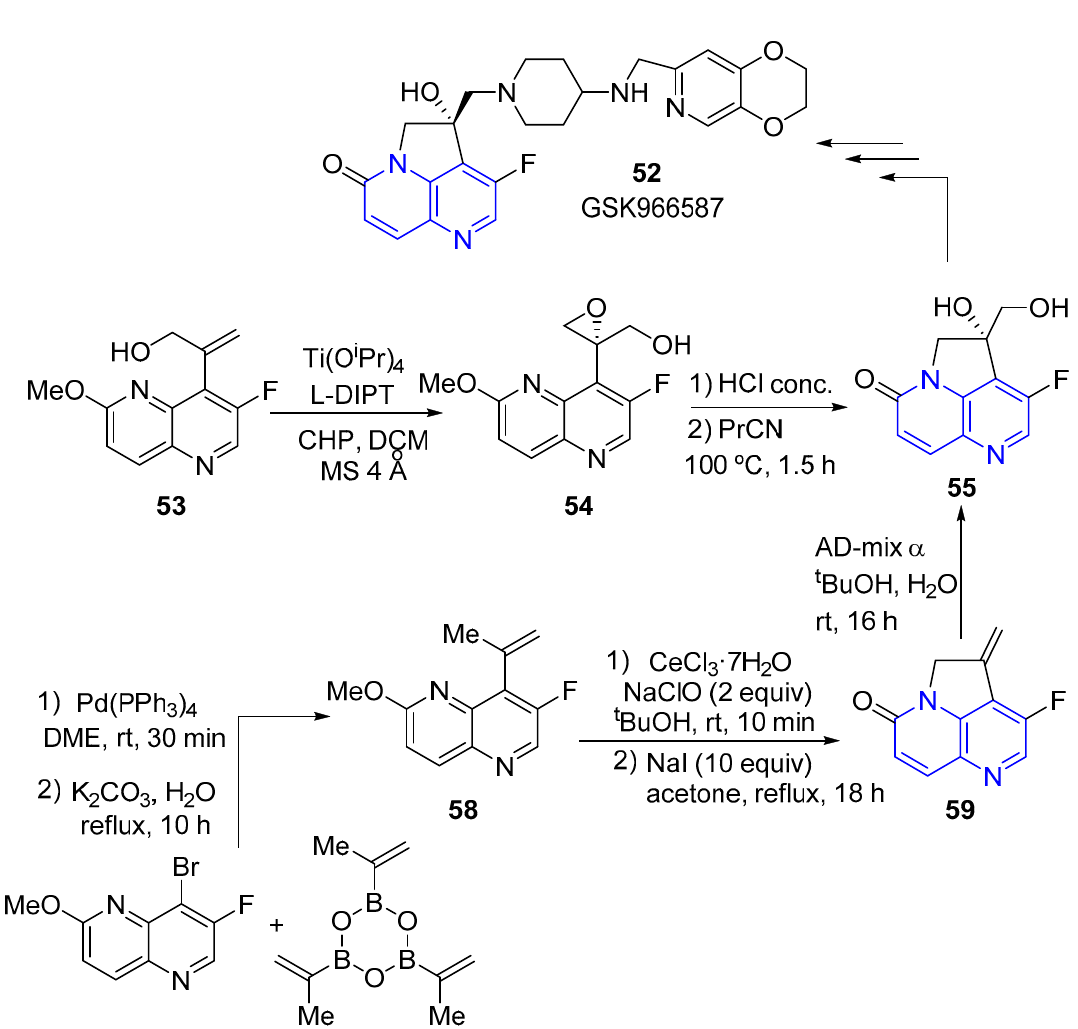
Scheme 16. Enantioselective total synthesis of the potent antibiotic